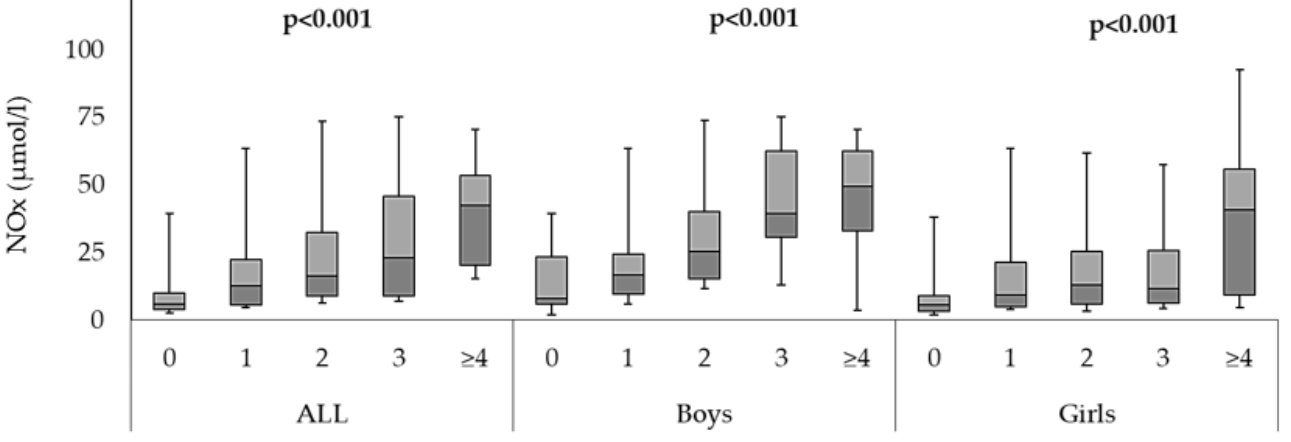
Figure 1. Comparison of serum NOx ( µ mol/L) levels and of clustering of MetS individual compo- nents in all participants, as well as in boys and girls.